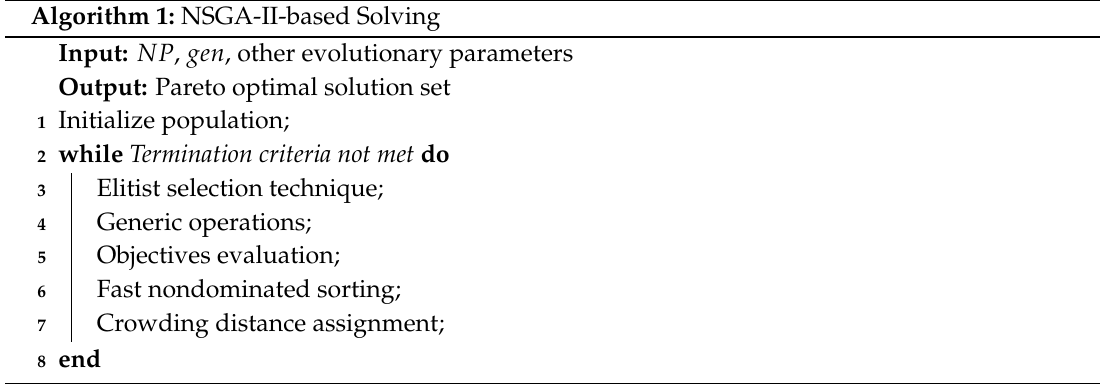
Algorithm 1: NSGA-II-based